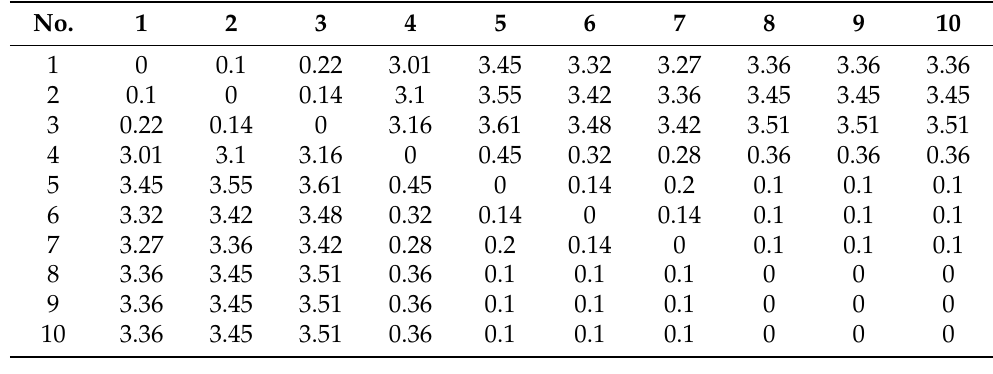
Table 2. Distance matrix for cluster K ( 256 ) .